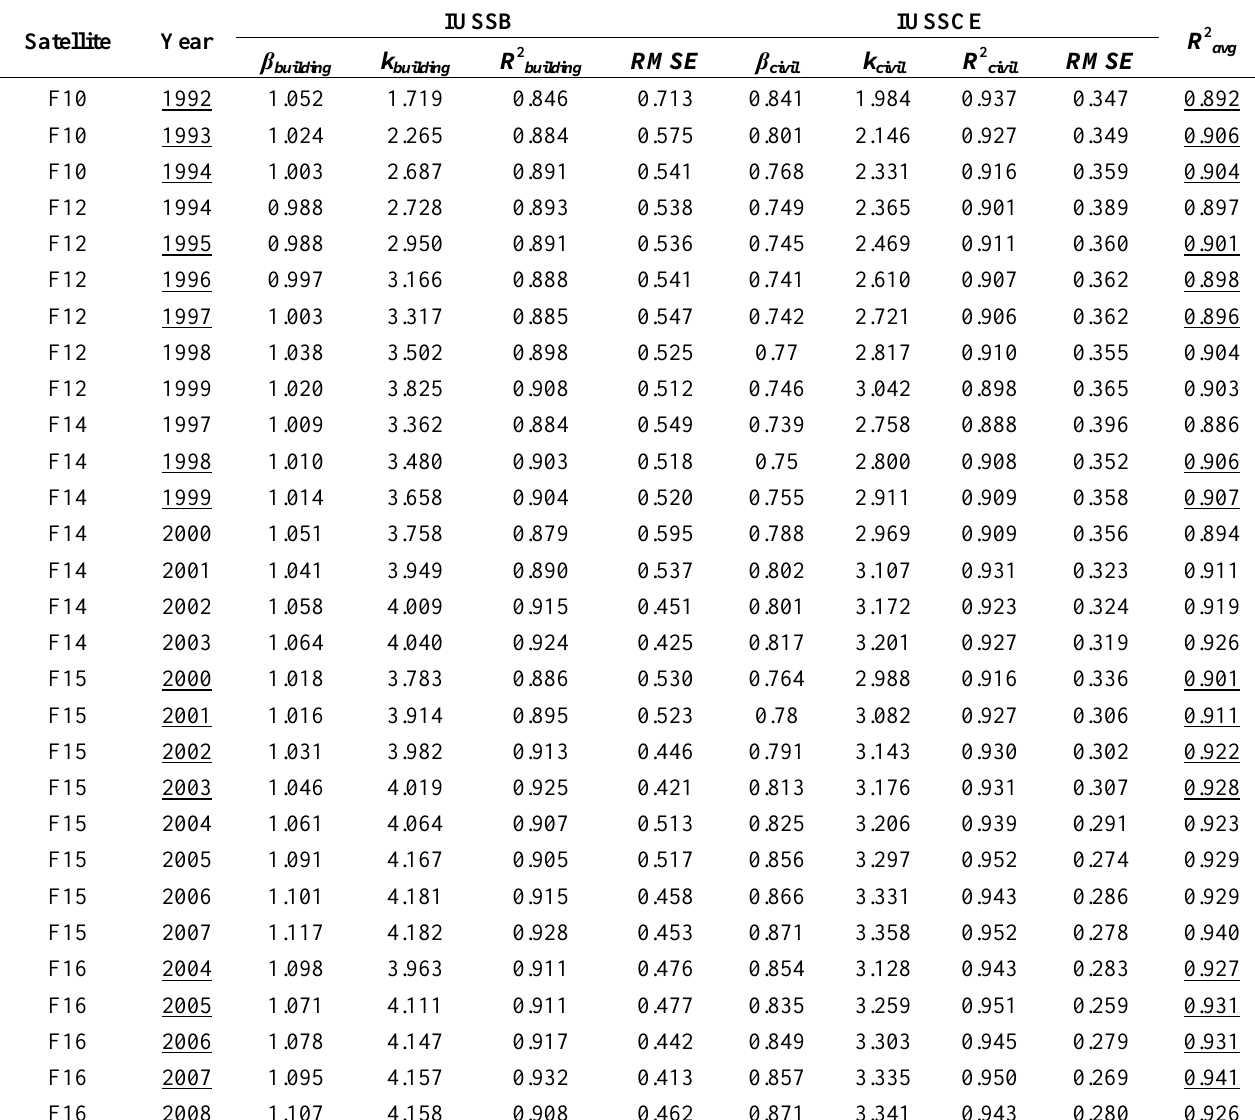
Table 1. Cross-sectional regression results for in-use steel stock for buildings (IUSSB) and civil engineering infrastructure (IUSSCE) based on five individual satellites. The years and averages ( R 2 ) of R 2 and R 2 with underlines indicate 17 imageries (out of 29) that avg building civil were selected to form the time-series